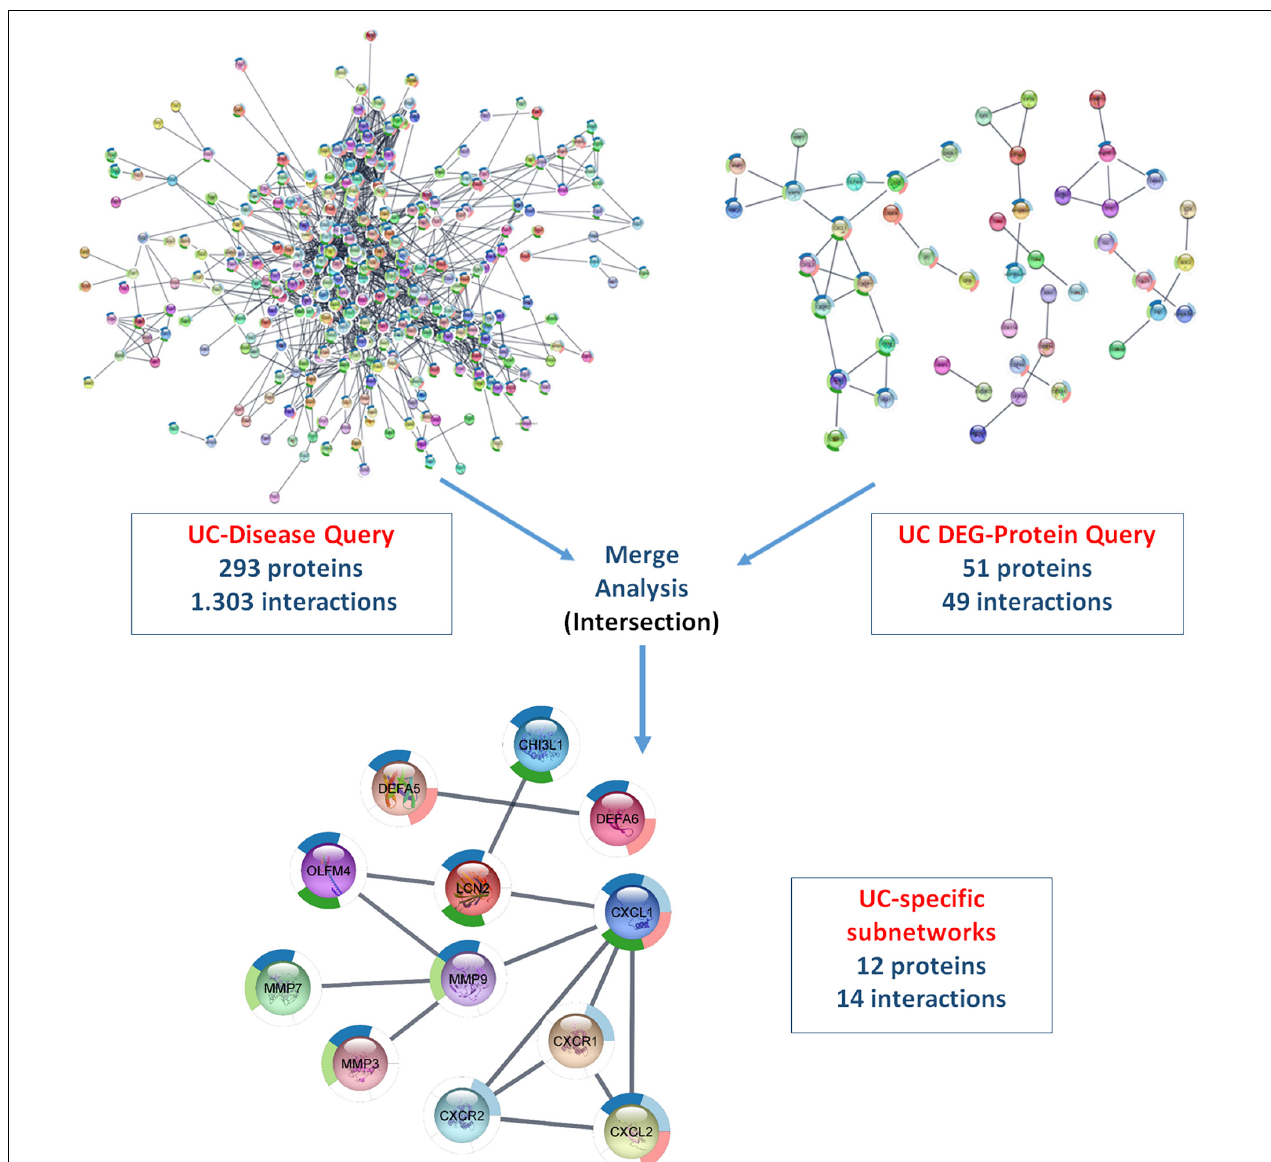
FIGURE 5 | Analyzing disease- and DEG-specific PPI networks for the discovery of a UC-specific subnetwork with StringApp.